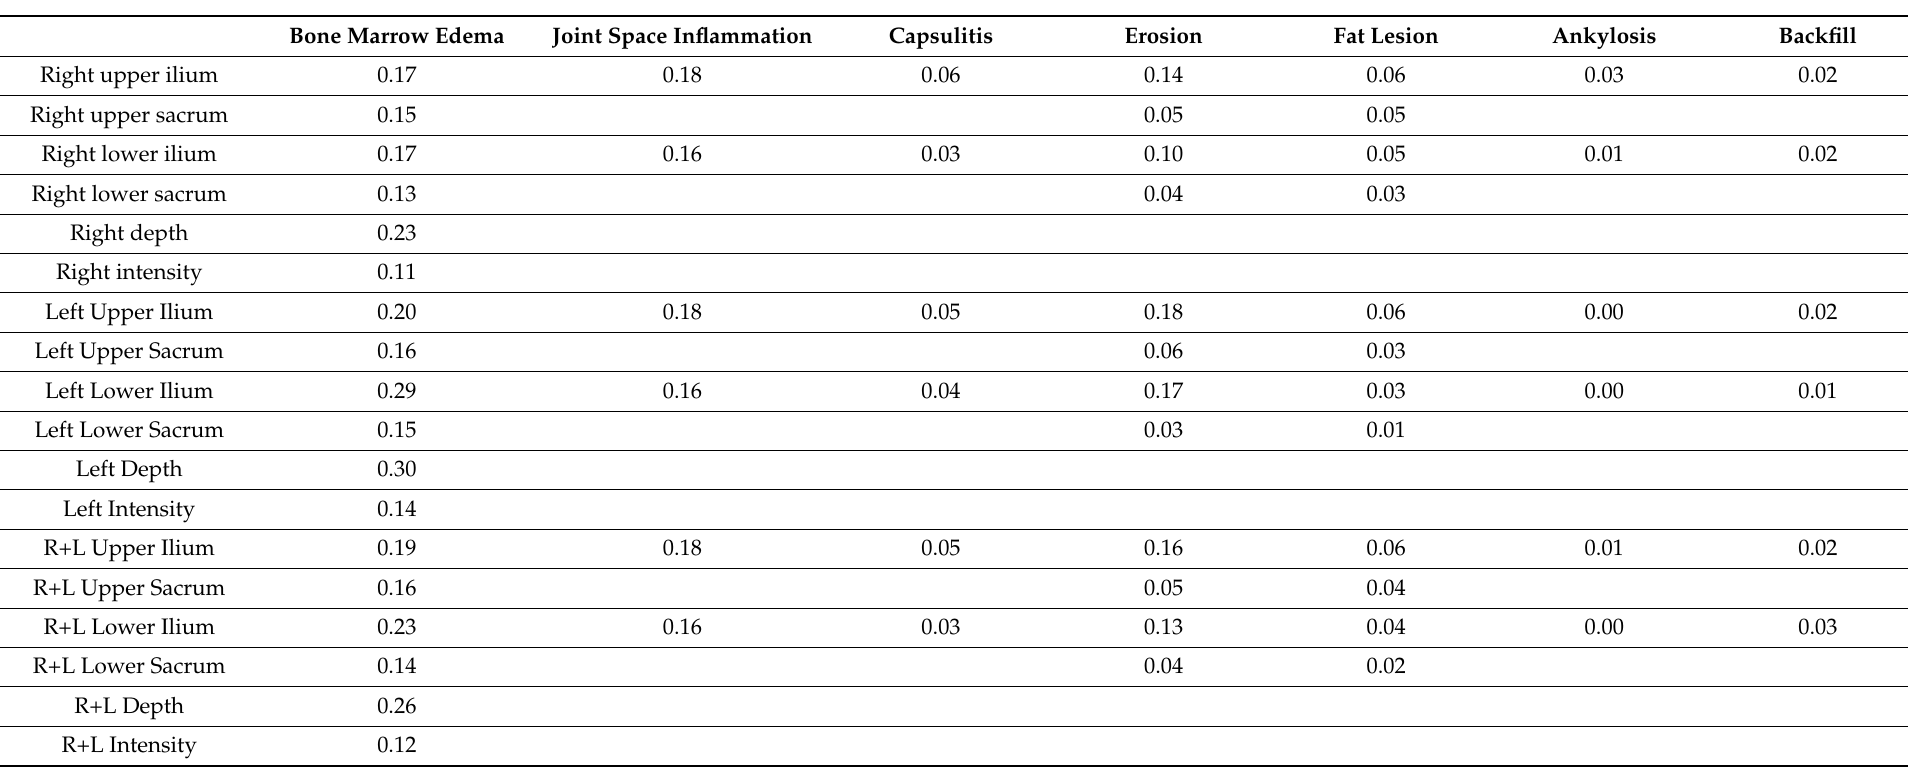
Table A2. SIJ location-wise intraclass correlation coefficients (ICC) for JAMRIS-SIJ